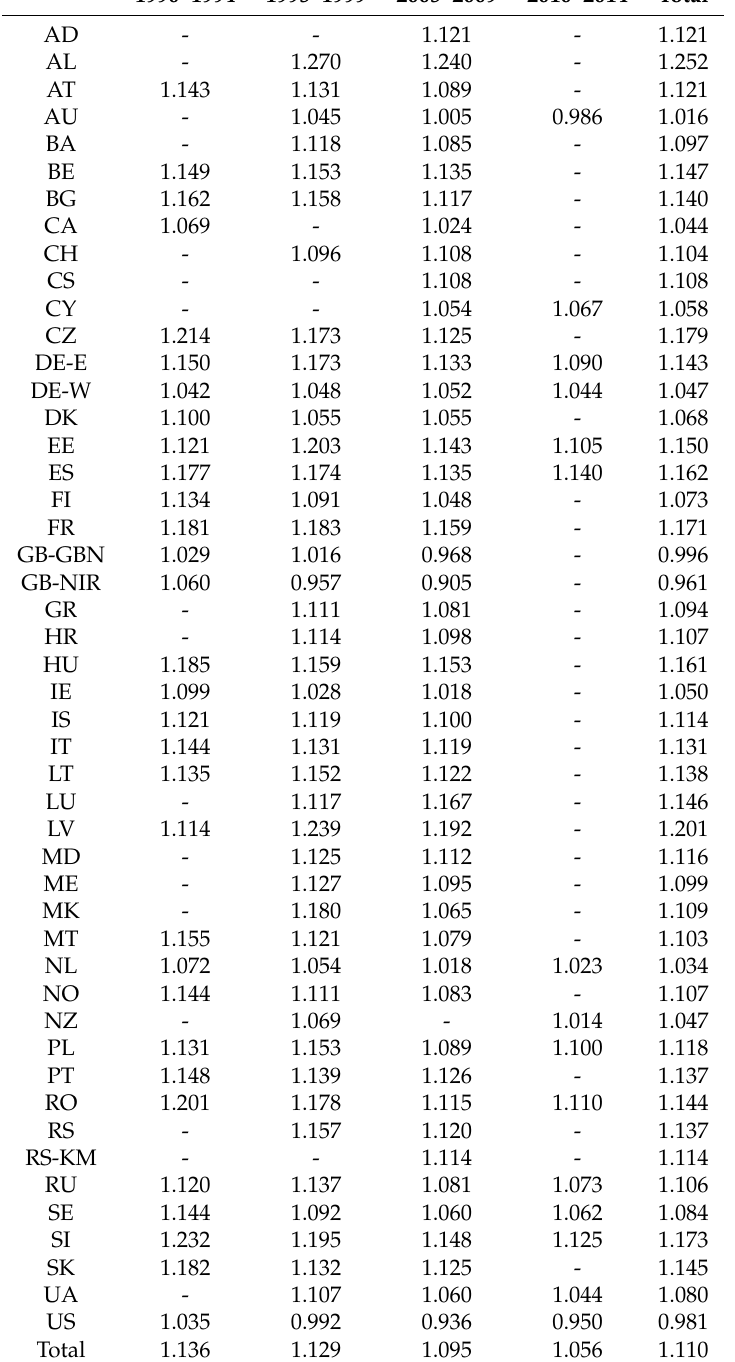
Table A2. The mean of the relative importance of work by country and